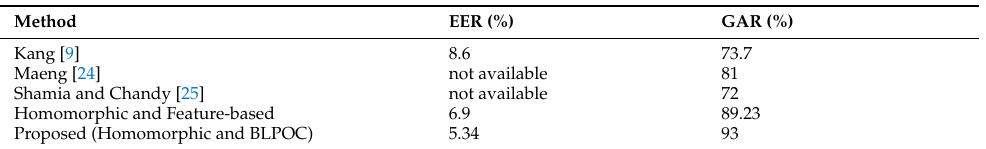
Table 3. The performance comparison of the proposed CSCD Method with the baseline methods on LDHF